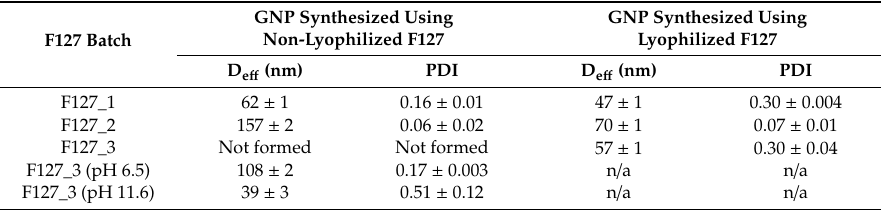
GNP Synthesized Using Lyophilized